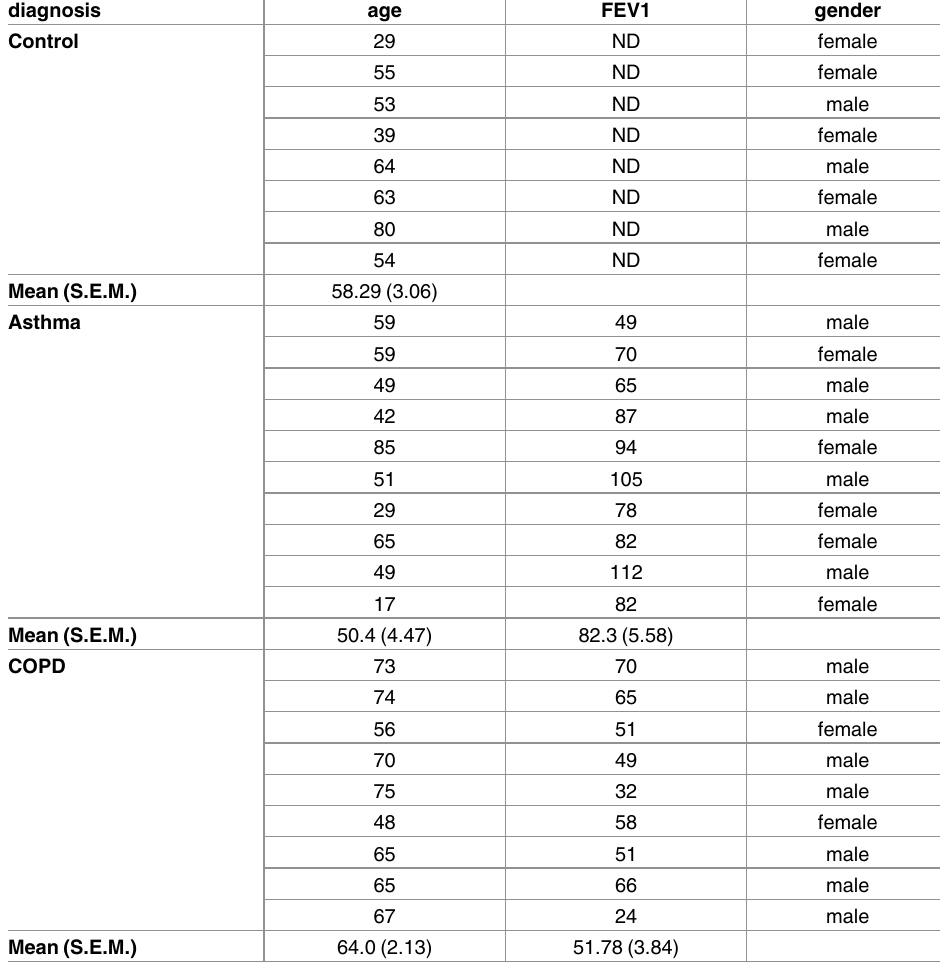
seeded into 8-well chamber slides (Thermofisher Scientific, Switzerland) and treated with RV and other chemical compounds or OM-85, as indicated in the treatment schemata provided in Fig 1B. After treatment, the cells were fixed after washing with PBS in 4% formalin (in PBS) for 5 minutes. The fixed cells were washed 2x with PBS and permeabilised for 15 minutes with 0.01% TWEEN-100 in PBS. Unspecific binding was blocked in 2% bovine serum albumin (30 minutes in PBS) before being incubated overnight (4˚C) with the anti-RV16 antibody (1:100 dilution). Following 3x washes with PBS, cells were incubated with an anti-mouse FITC labelled antibody (Abcam, Switzerland) for 1 hour at room temperature. After 3x washes with PBS, the number of RV positive cells was counted by immunofluorescence microscopy (EVOS FLoid cell imaging station, Thermofisher Scientific) and nuclei were stained for cell counting using the distributor’s live cell reagent (Thermofisher Scientific).